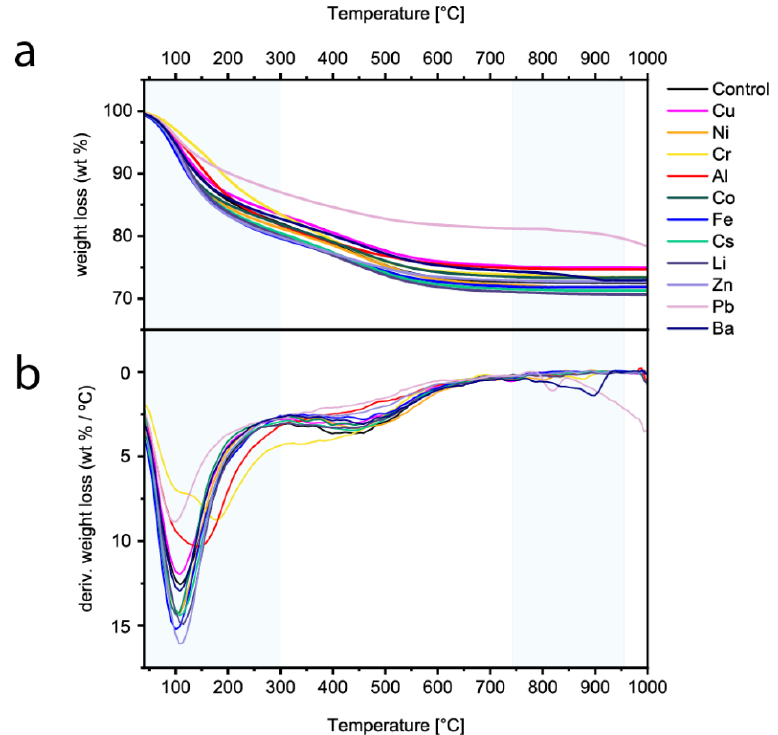
Figure 3. ( a ) Thermogravimetric data weight loss in % from 40 to 1000 °C; ( b ) derivative weight loss in